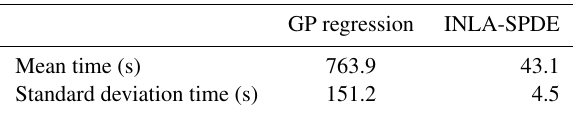
Table 1. Computational time for the TEC surface fitting and the TEC value